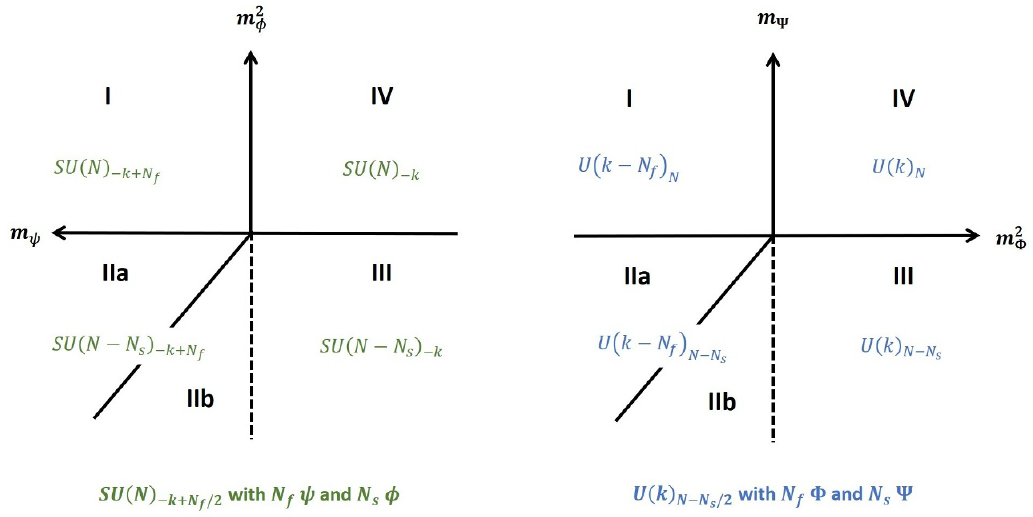
Figure 3. Phase diagram of the (cid:13)avor-bounded master duality. Critical theories separating phases are the black lines. The dotted black lines represent a critical theory that would be present for N > N s , but is not present for N = N s